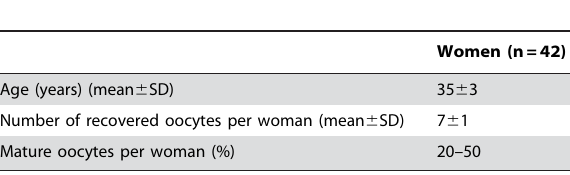
Table 2. Details of the in vitro maturation